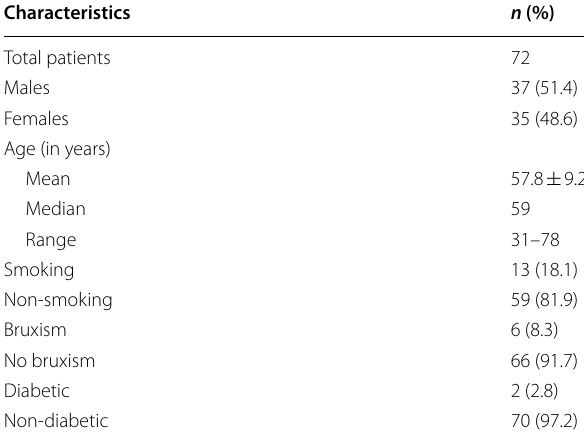
Table 1 Zygomatic implant techniques Buccal concavity Alveolar ridge Surgical technique